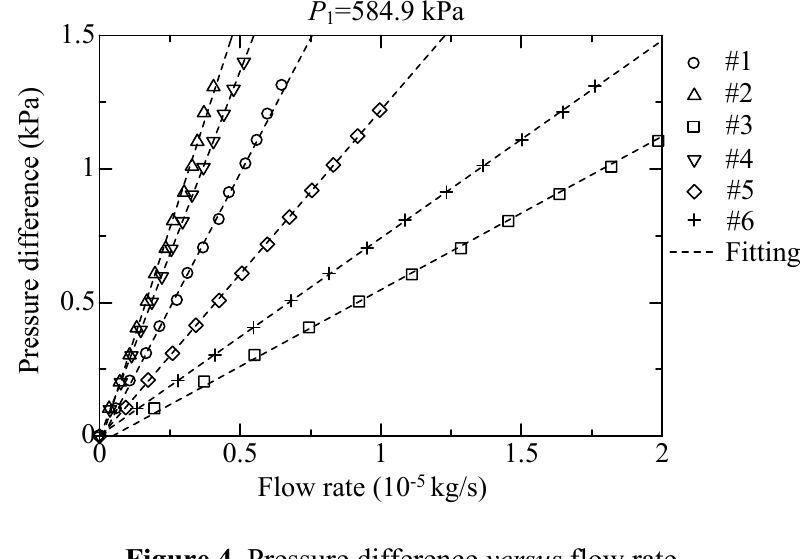
Figure 4. Pressure difference versus flow rate.